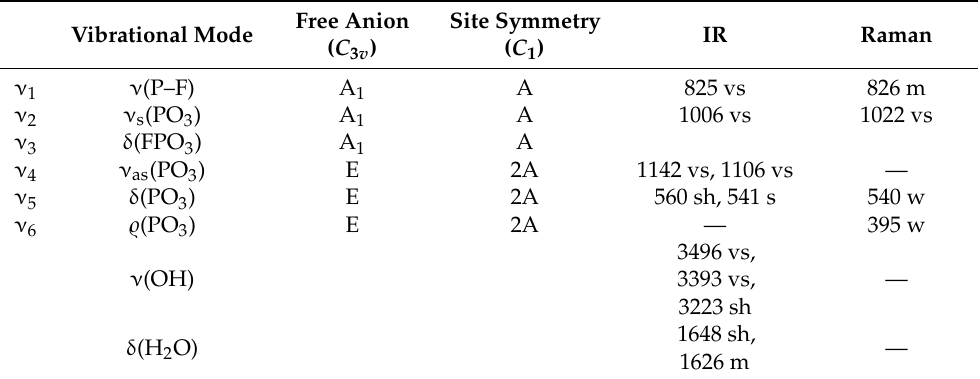
Table 4. Site symmetry analysis of the PO 3 F 2 − vibrations in the lattice of CdPO 3 F(H 2 O) 2 and assignment of IR and Raman bands (band positions in cm − 1